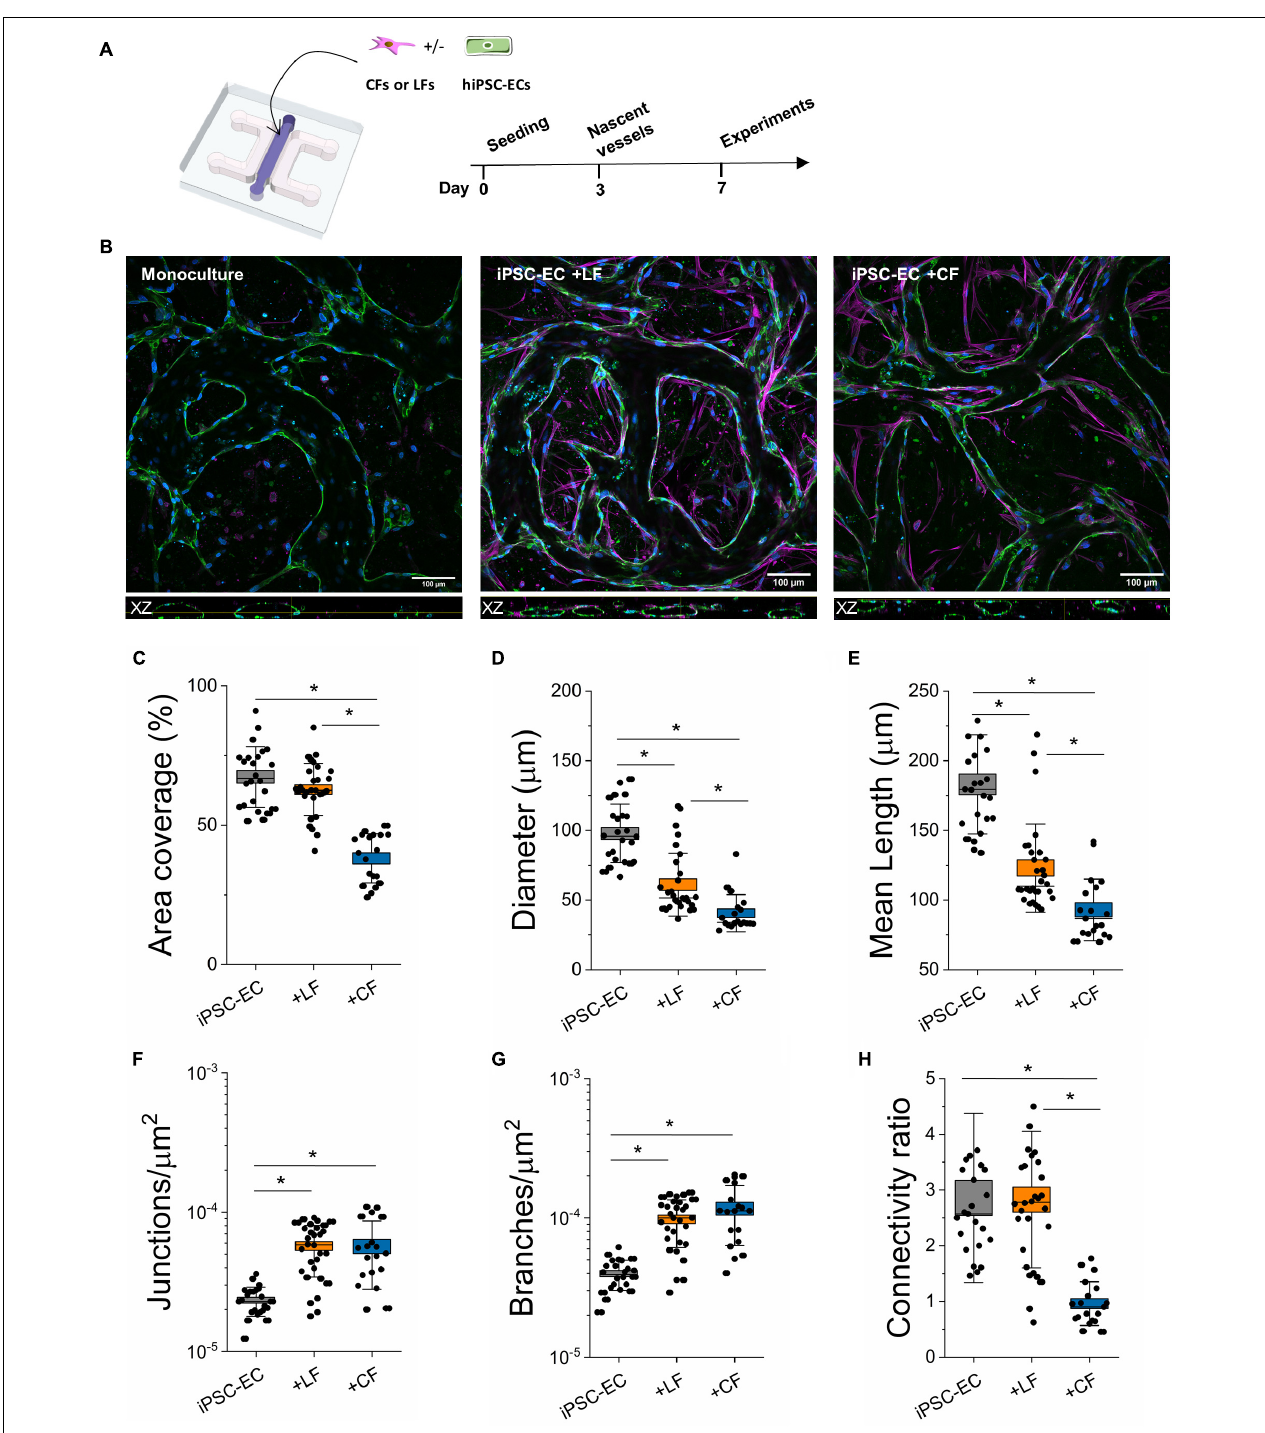
FIGURE 1 | Stromal cells alter the morphology of hiPSC-EC derived microvessels. (A) Schematic of the on-chip PDMS device used to generate hiPSC-derived microvessels. Cells are encapsulated within a fibrin hydrogel in the central channel and form microvascular networks as early as day 3. (B) Representative confocal images of microvascular networks taken at 20x. L-R: Microvessels derived from hiPSC-EC monoculture, hiPSC-EC and lung fibroblast co-culture, and hiPSC-EC and cardiac fibroblast co-culture. Microvessels were stained for a known endothelial marker, CD31 (green), and were counterstained by phalloidin (magenta) and Dapi (blue). Top: XY plane of formed microvascular networks. Bottom: orthogonal (XZ-plane) images of microvessels showing open lumens. (C–H) Comparison of morphological parameters between mono- and co-cultures. Shown are data from 3 separate experiments with ≥ 10 devices per condition. Box plots demonstrate SD (outer whiskers) and SE (box edge). Significance is shown by * P < 0.05, using one-way ANOVA and a subsequent Tukey means comparison test.